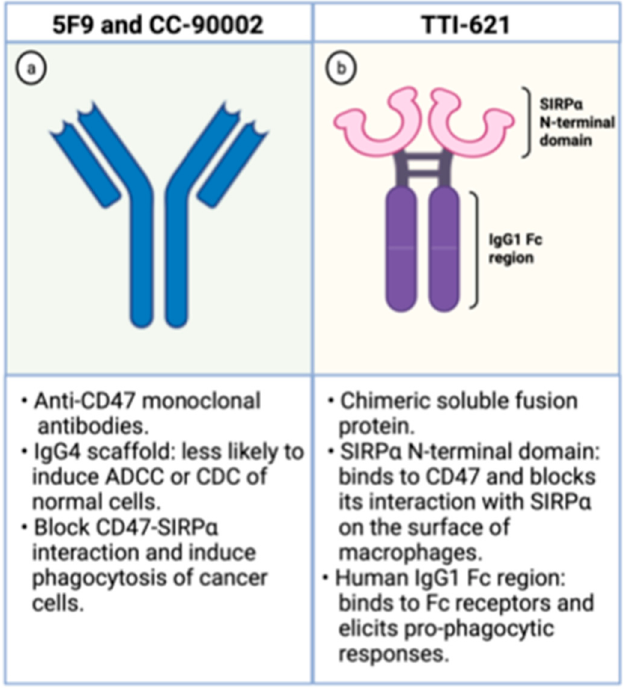
Figure 3. Schematic representation of CD47 blocking agents. On the left ( a ), schematic representation of anti-CD47 monoclonal antibodies. On the right ( b ), schematic representation of TTI-621, a chimeric fusion protein composed by the SIRP α binding domain and the human IgG1 Fc region. Created with Biorender.com.